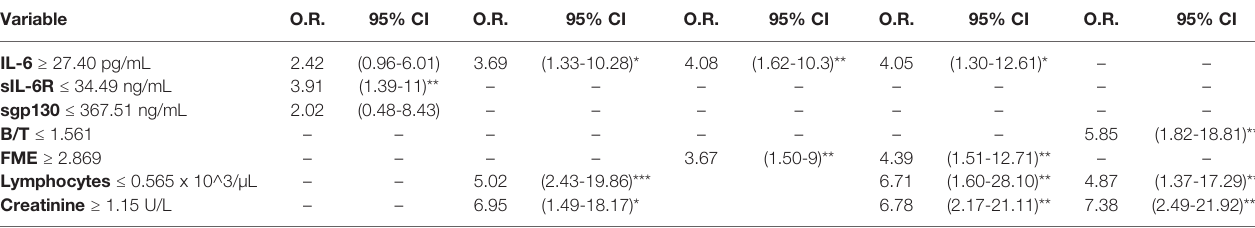
TABLE 3B | Multivariate logistic regression analyses of IL-6 signalling biomarkers as predictors of COVID-19 mortality.